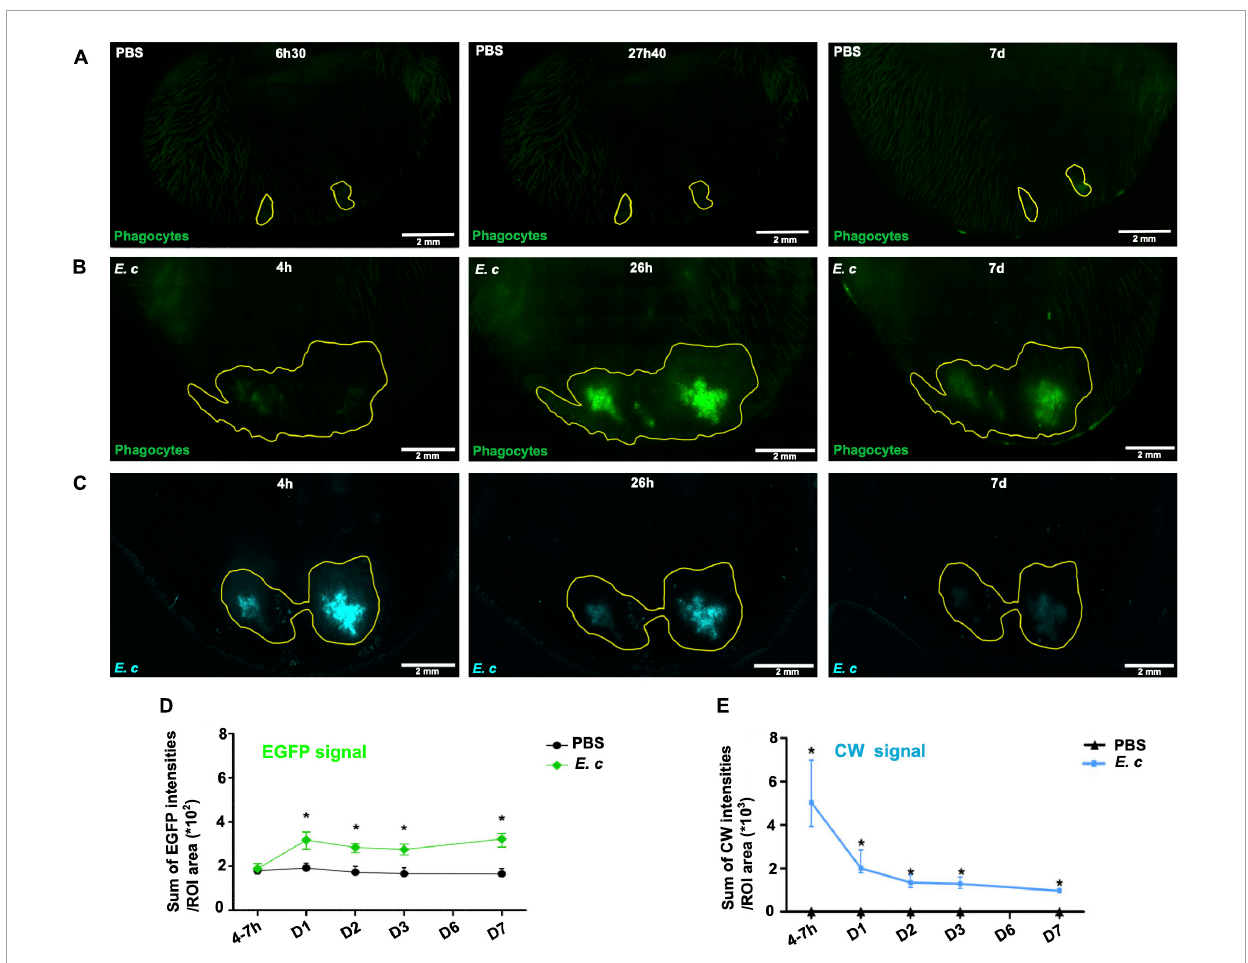
FIGURE2 Inflammatory responses after micro-injection of calibrated inocula of Encephalitozoon cuniculi spores in the mouse ear pinna. (A–C) Reconstituted confocal images of the mouse ear pinna tissue showing the maximal projection intensities of the EGFP and CW signals. LysM-EGFP transgenic mice were microinjected with PBS (A) or CW-labeled E. cuniculi spores ( E. c ) (B,C) at early (4–6 h30) and later (after 24 h pi) time points. The EGFP fluorescence (green) signal corresponds to phagocytes (PMN and Mo). An ROI was defined around the phagocyte recruitment area 26 h pi or 27 h 40 post-injection (PBS) (yellow line) where the “Sum of EGFP fluorescence intensities” was measured. The same ROI was then applied to the images of the other kinetic points (A,B) . The CW fluorescence (blue) signal corresponds to E. c spores. An ROI was defined around the inoculum area 4 h pi (yellow line) where the “Sum of CW fluorescence intensities” was measured. The same ROI was then applied to the images of the other time points (C) . One representative experiment is shown for each group of mice from 2 independent experiments. Scale bar: 2 mm. Ratios of the sum of EFGP (D) or CW (E) fluorescence intensities to ROI area for infected ( E. c ) or control (PBS) mice. *: Statistically significant difference compared with the control group (PBS) with p < 0.05. Mann-Whitney statistical test. Four independent experiments, n = 8 tissues ( E. c ) and n = 14 control tissues (PBS).